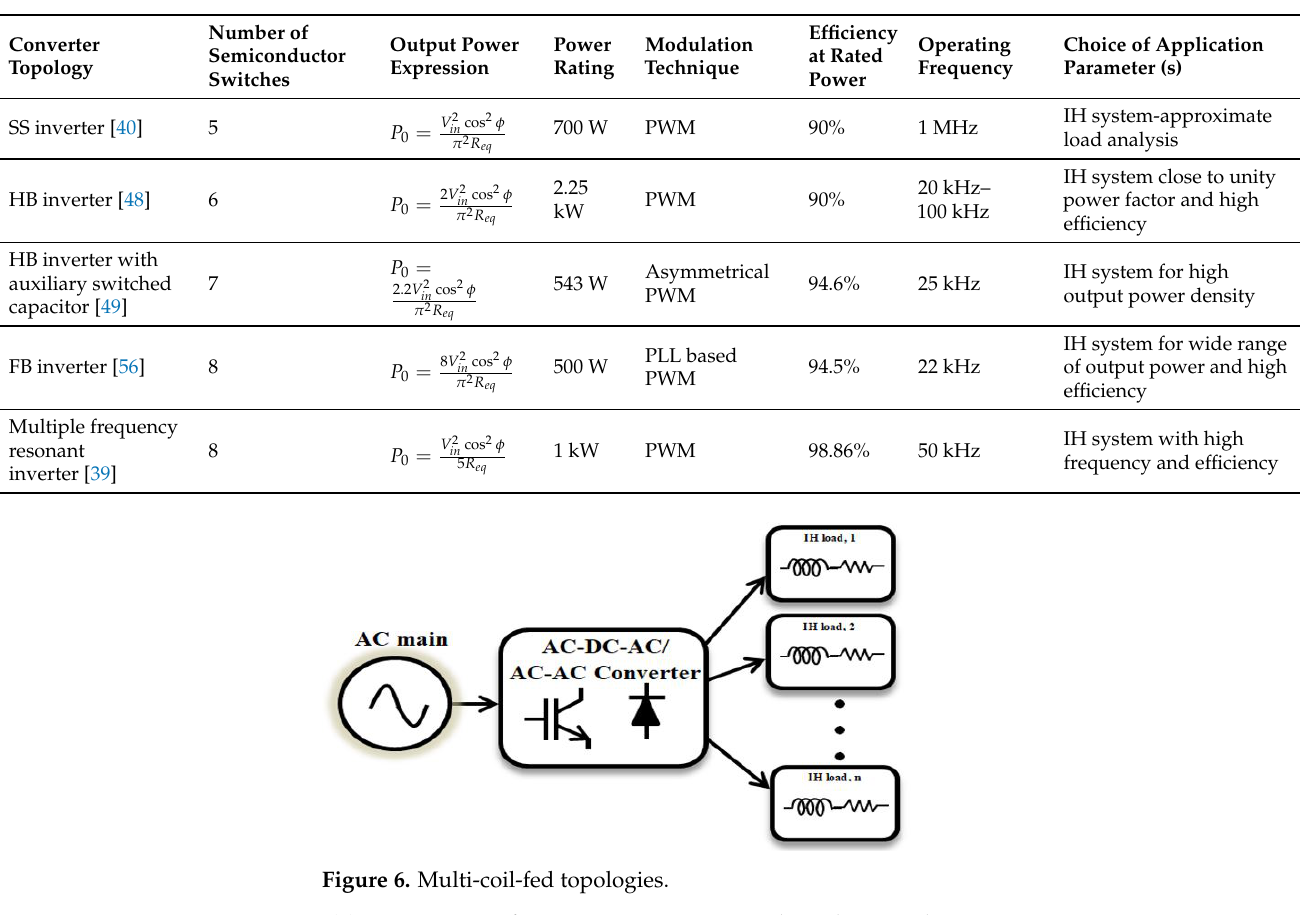
Table 2. Summary of various parameters in AC–DC–AC VSI-fed IH topologies.